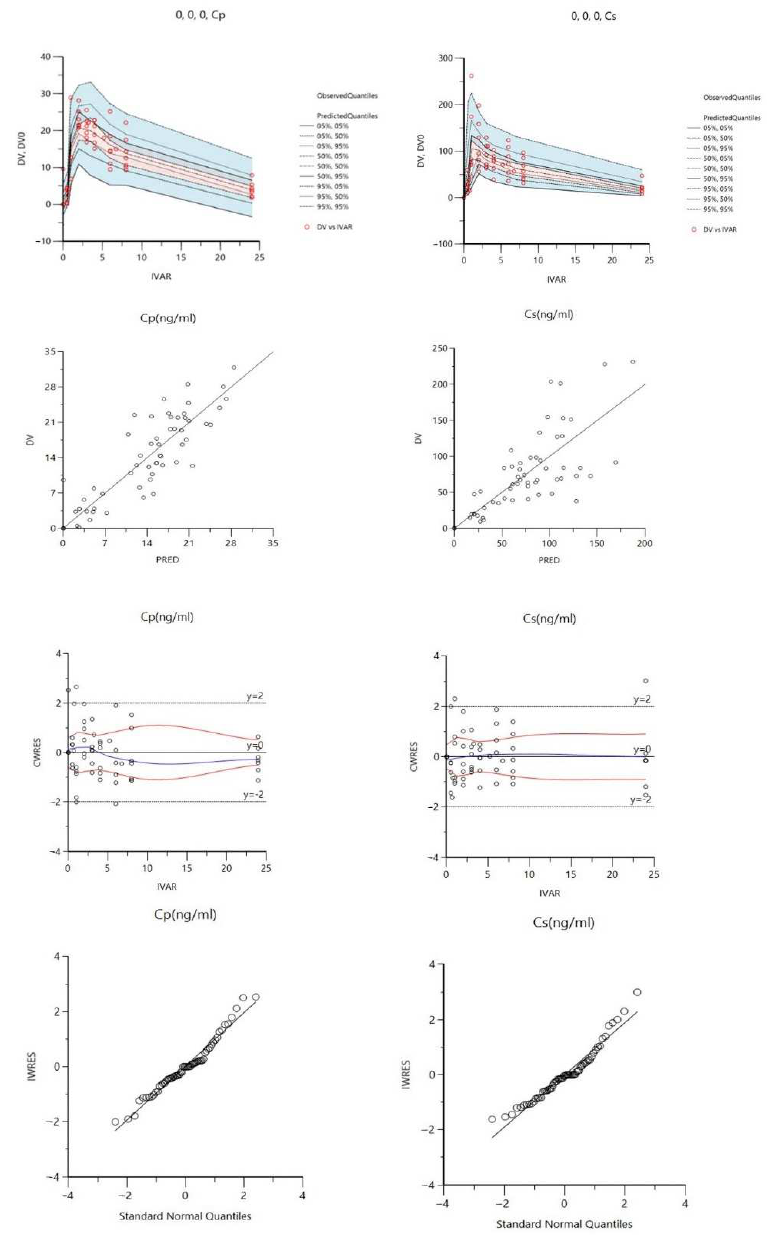
Figure 7. Best fit model result plots of Matr in human plasma and saliva from Model C (C p : plasma concentration, C s : saliva concentration, IVAR: independent variable—time, DV: dependent variable—blood concentration, IPRED: individual prediction, CWRES: conditional weighted residual)